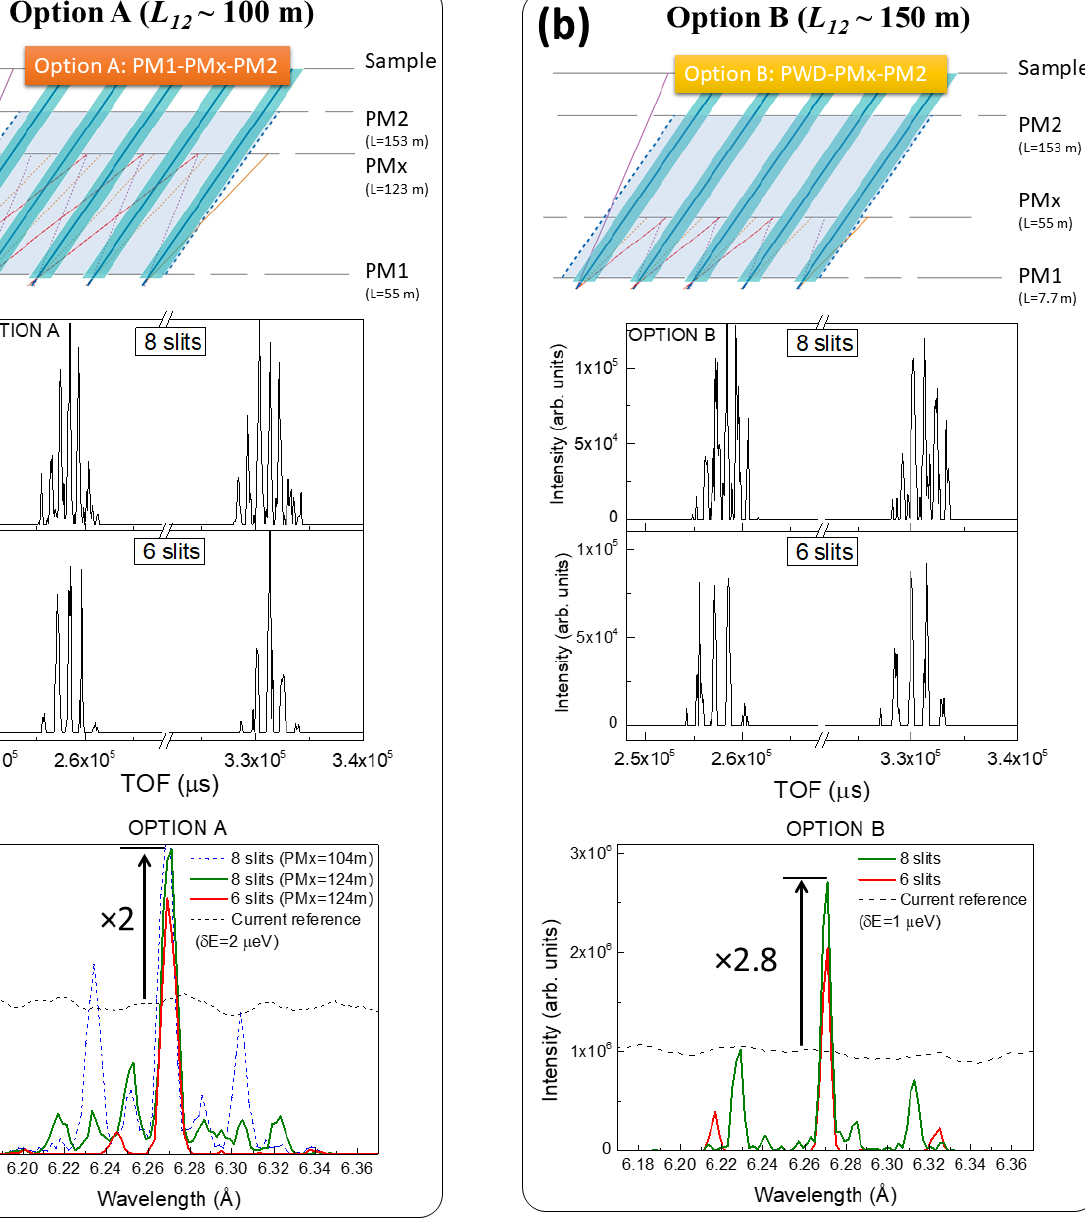
Figure 6. Sketch illustrating only the pulse multiplication chopper cascade for ( a ) Option A and ( b ) Option B, together with their respective wavelength and TOF spectrum at the sample position with PMx running at f = 252 Hz. All spectra are compared with their current reference, i.e., the spectrum obtained with the current chopper layout and analogous energy resolution. Table 2. Main parameters (location, L, slit size, a, frequency, f, and whether the chopper is counter rotating double disk (CR) or single disk (SD)) for the proposed chopper layouts for pulse multiplication in MIRACLES, using three fast choppers.